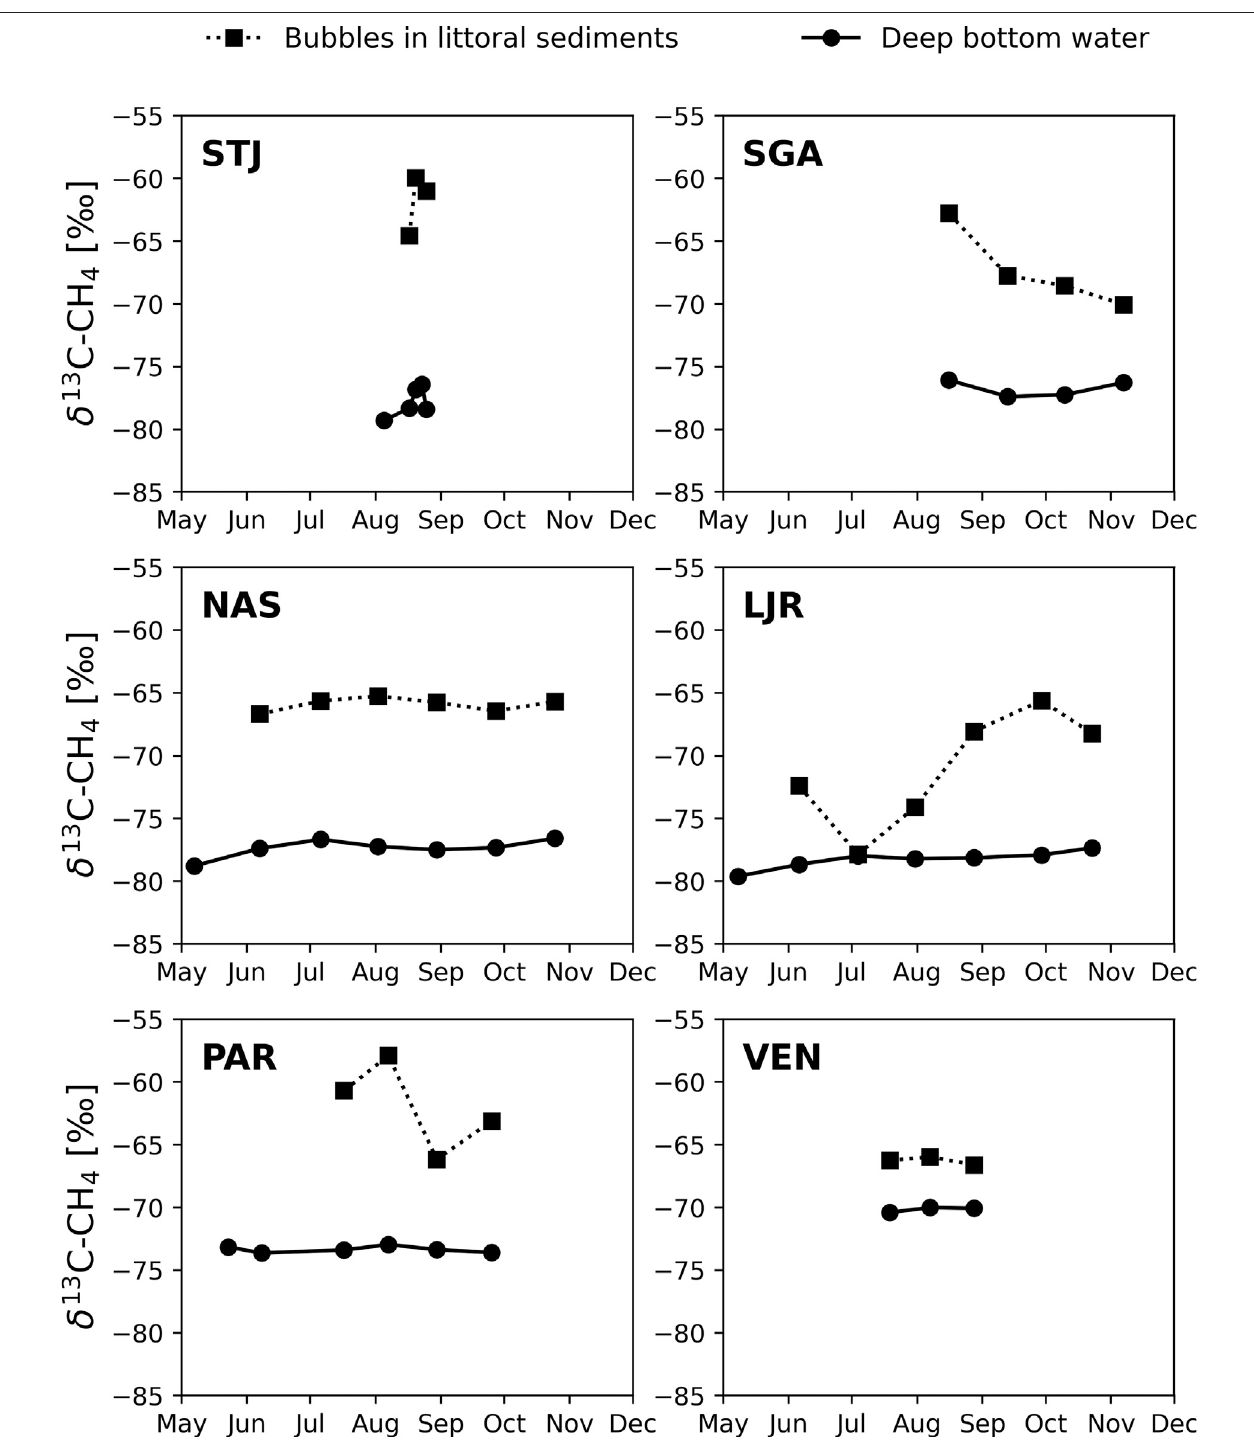
FIGURE3| δ 13 C-CH 4 intheanoxicwaterclosetothebottomatthedeepestpoint(dotswithcontinuouslines)andinthebubblesinlittoralsediments(squareswith dotted lines) in six lakes.